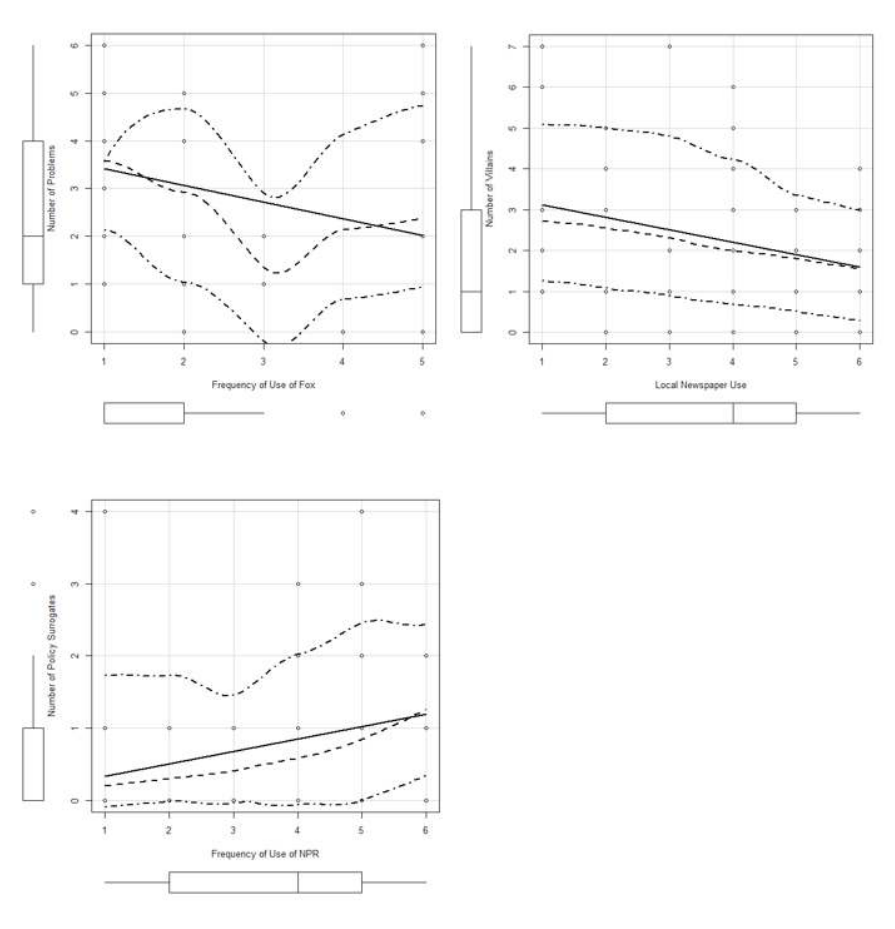
Figure 2: Relationship between Media Use and Narrative